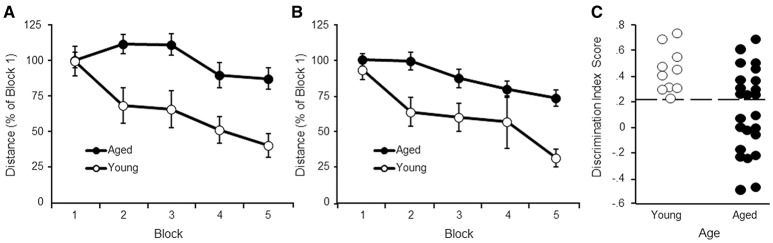
Performance on the water maze task. Symbols indicate the mean (±SEM) escape path length to the escape platform during 5 training blocks on the (A) cue and (B) spatial discrimination tasks for young (open symbols) and aged (filled symbols) animals. (C) Acquisition of a spatial search strategy. Individual discrimination index scores for young (open symbols) and aged (filled symbols) animals. The dashed line indicates the cut-off for behavioral classification of aged-impaired (AI) and aged-unimpaired (AU) animals.